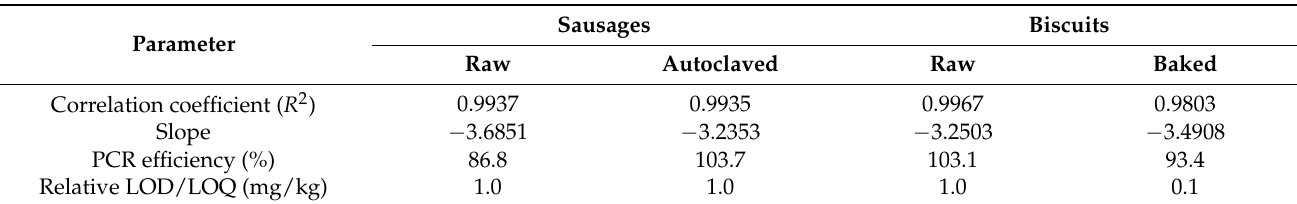
Table 2. Calibration curve parameters obtained by quantitative real-time PCR targeting cytochrome b gene, using model mixtures of sausages and biscuits containing T. molitor , before and after thermal